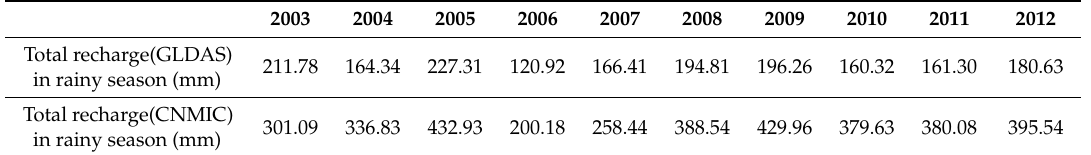
Table 4. The YRSR total recharge (two versions) in rainy season (Jun, Jul, Aug, Sept) during